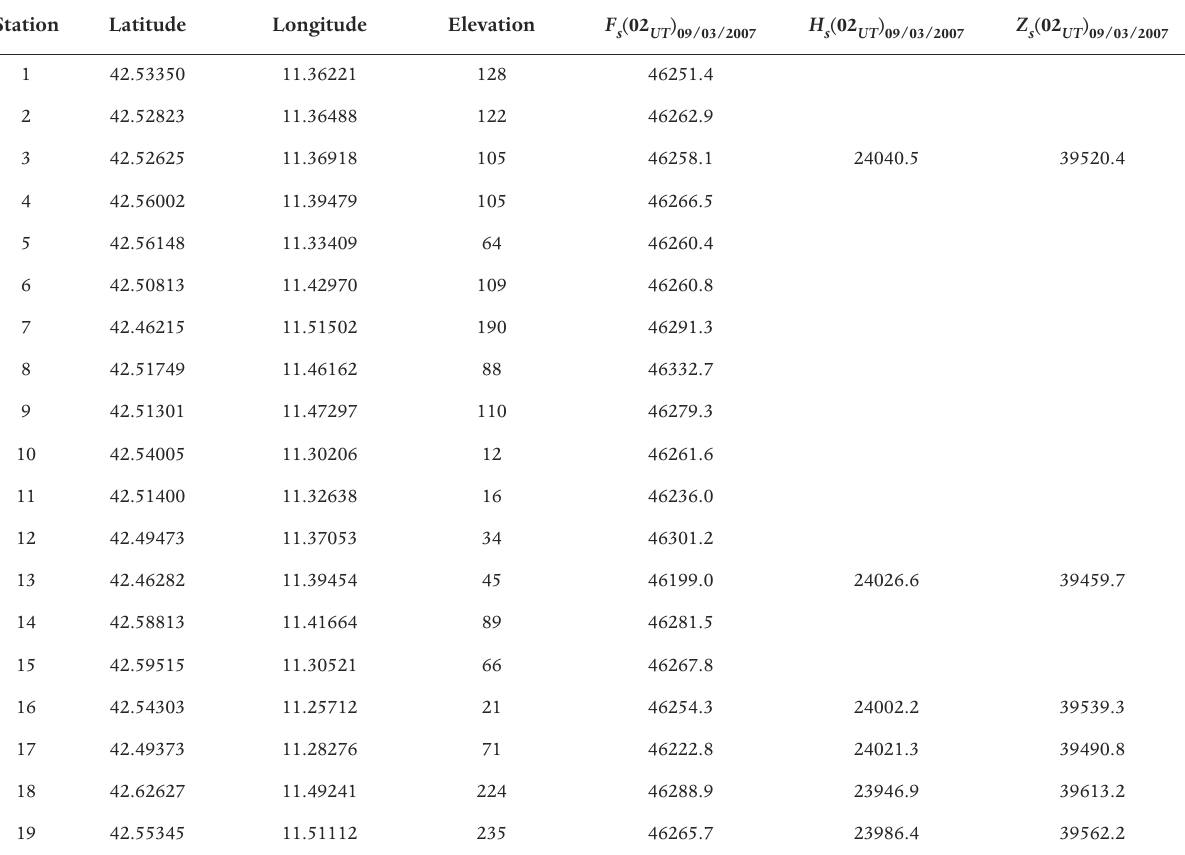
hours of day September 3rd, UT